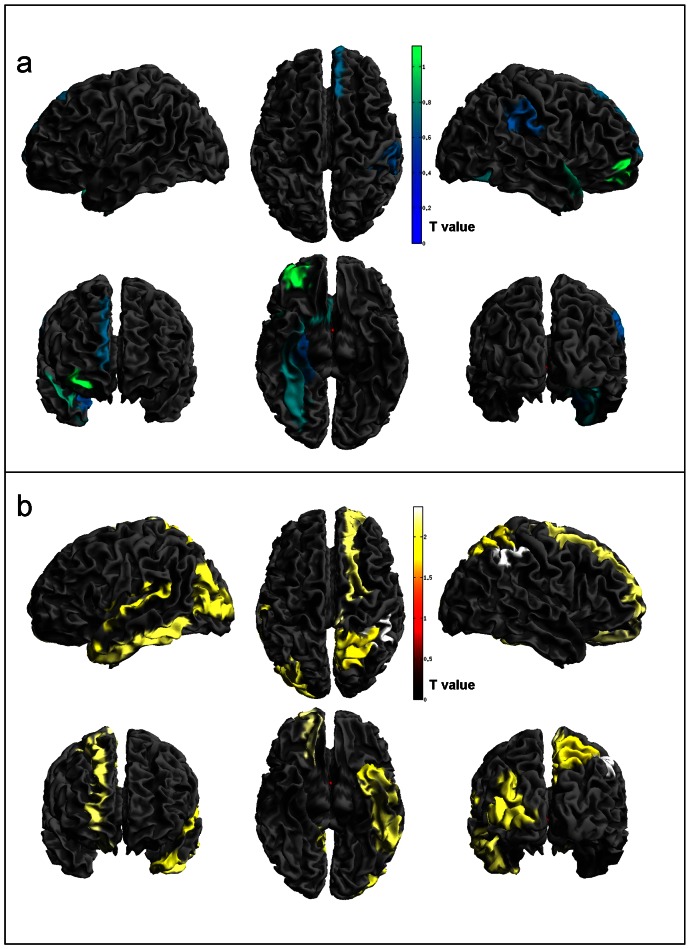
Regions of significant cortical thickness changes in PD-MCI vs. PD-CNT.Panel a) PD-MCI atrophy; b) PD-MCI hypertrophy. Statistical threshold used T = 1.69, p<0.05.